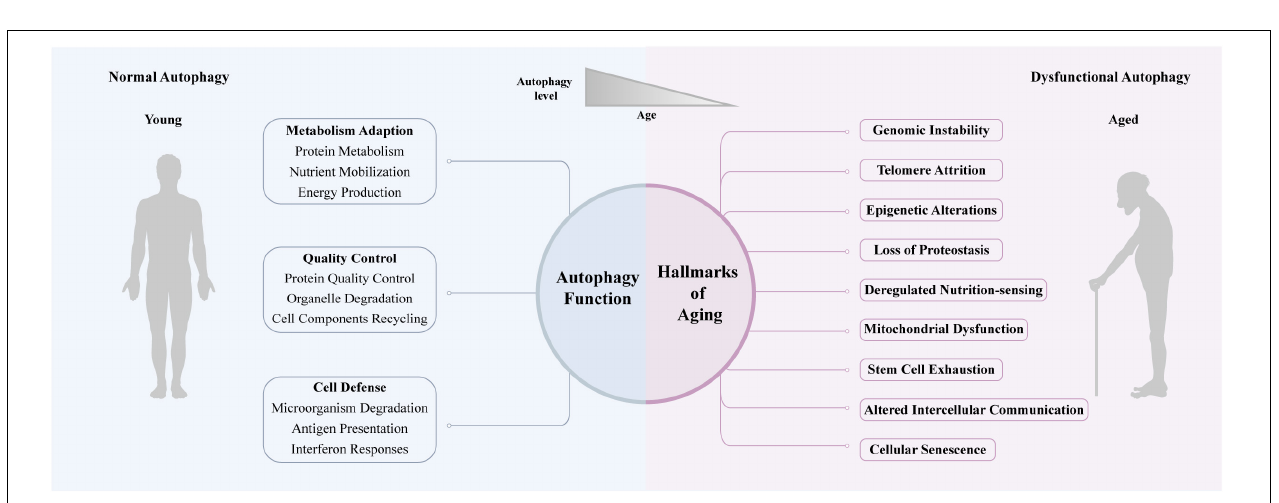
FIGURE 2 | Autophagy and aging. Quality control, metabolic adaption and cellular defense are the three main functions of autophagy, and functional autophagy promotes health during youth. Autophagy declines with aging, which is often associated with the hallmarks of aging and promotes age-related